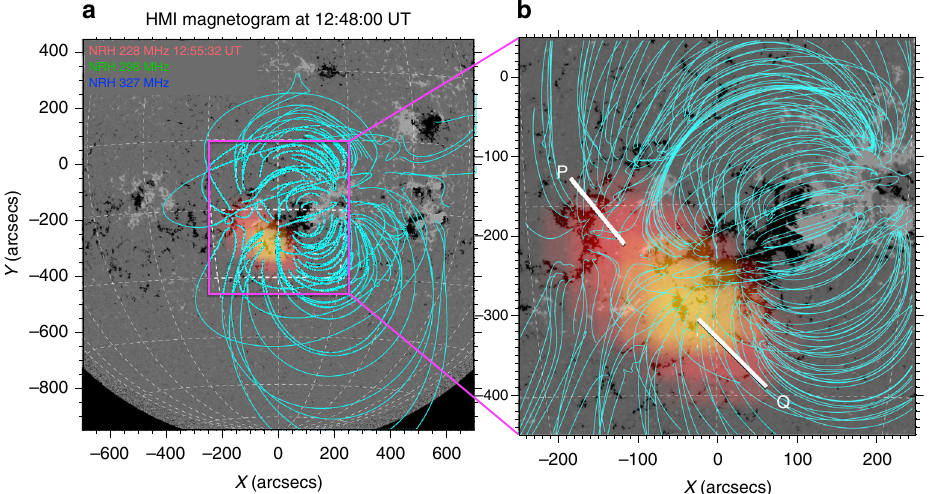
Fig. 3 Pulsation radio source location in the active region magnetic fi eld. a SDO HMI magnetogram with a PFSS extrapolation of the quiet AR magnetic fi eld shown in blue. The pulsating radio source is overlaid as a three-colour image of NRH 228 MHz (red), 298 MHz (green) and 327 MHz (blue) at 12:55:32 UT. b A zoom of the active region with a NLFFF magnetic extrapolation in blue. At least part of the radio source is located at point P, with some emission extending into the closed fi eld region of the magnetic loop footpoints, labelled Q. Note the region above the higher negative fi eld strength in the magnetogram (black regions) shows greater intensity in the higher frequencies (yellow colouration), indicating that this emission is likely related to